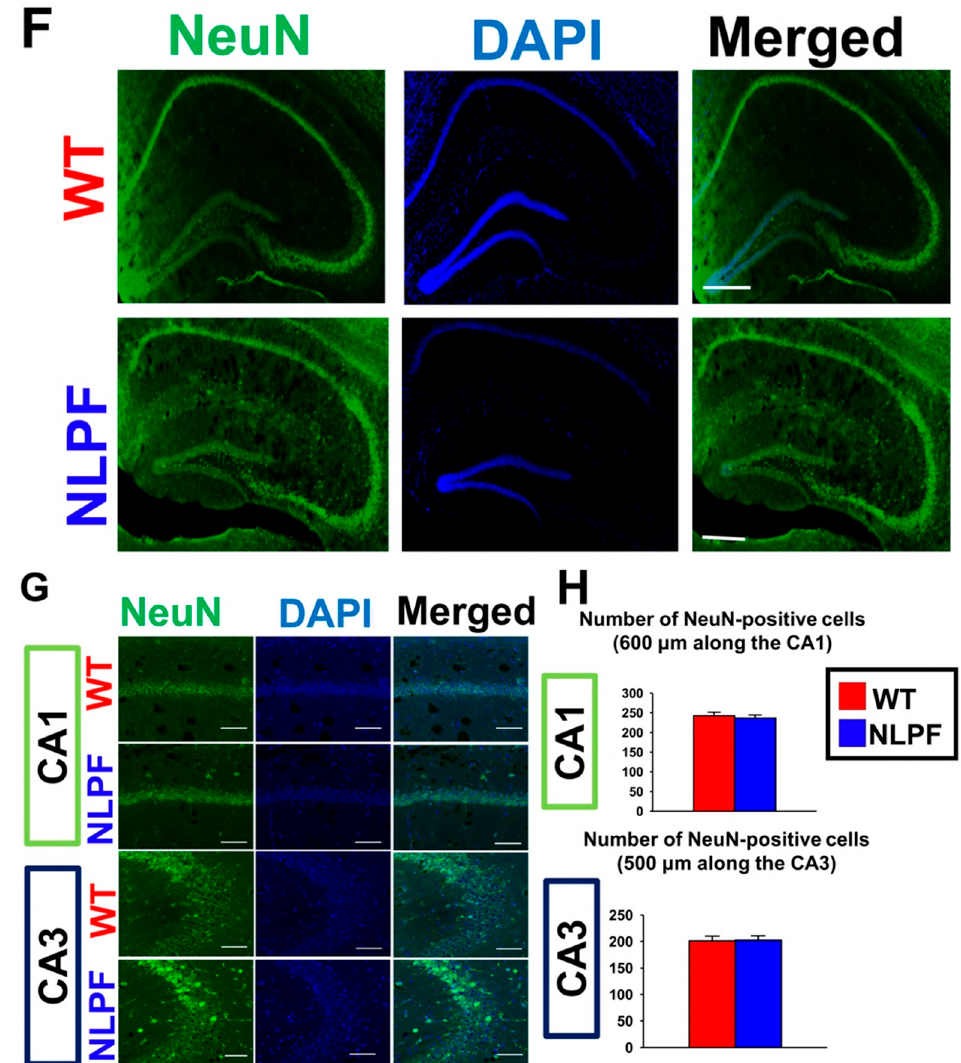
Figure 2. Alzheimer’s disease (AD)-related histological changes in the brain of APP NL-P-F/NL-P-F mice. ( A ) The A β plaque deposition was detected by 82E1 in the hippocampal CA1, DG, and cortex of APP NL-P-F/NL-P-F mice from three to twelve months. The scale bar indicates 1 mm in representative coronal sections and 100 μ m in each region). ( B ) The A β plaque area in the hippocampal CA1, DG, and the cortex of APP NL-P-F/NL-P-F mice from three to twelve months. WT ( n = 6) and NLPF ( n = 7–9). ( C , D ) Representative ( C ) fluorescent and ( D ) confocal images of tau phosphorylation were detected by PHF-1 (Ser396/Ser404) in the hippocampal CA1, CA3, and DG after twelve months. The scale bar indicates ( C ) 1 mm (50 µ m in enlarged images) and ( D ) 50 µ m (25 µ m in enlarged images of CA1 area). ( E ) After twelve months, the phosphorylated tau-positive area (% of total area) in the hippocampal CA1, CA3, and DG. WT and NLPF ( n = 6). ( F , G ) After twelve months, representative ( F ) fluorescent and ( G ) confocal images of NeuN in the hippocampal CA1 and CA3. The scale bar indicates ( F ) 250 µ m (50 µ m in enlarged images) and ( G ) 50 µ m. ( H ) After twelve months, the number of NeuN-positive neurons in the hippocampal CA1 and CA3. WT ( n = 17 slices/6 mice), NLPF ( n = 13 slices/6 mice). The values indicate the mean ± SEM. * p < 0.05, ** p < 0.01, *** p < 0.001, compared with age-matched WT.